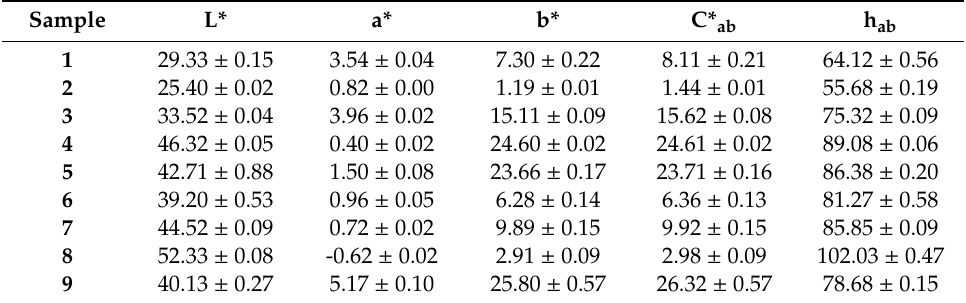
Table 3. Colorimetric parameters obtained by CIELAB analyses performed on hemp seed oils 1–9. Sample L*